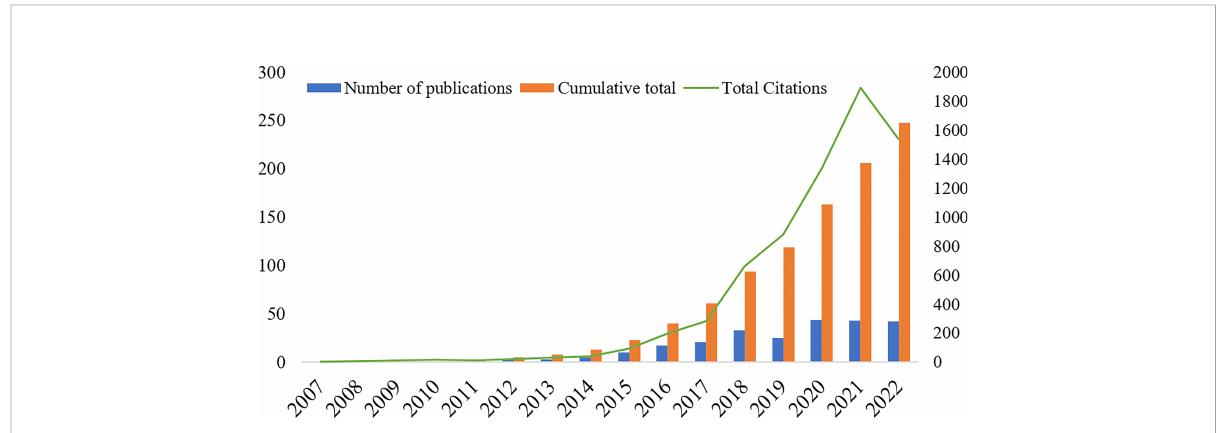
FIGURE 2 Number of annual publications, annual cumulative number of publications and annual total citations of related literature from 2007 to September